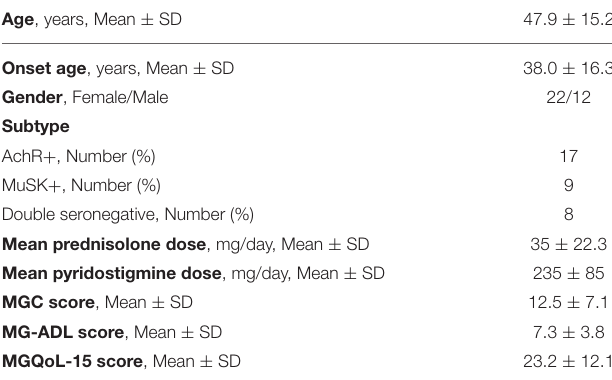
TABLE 1 | Baseline demographic and clinical characteristics of the